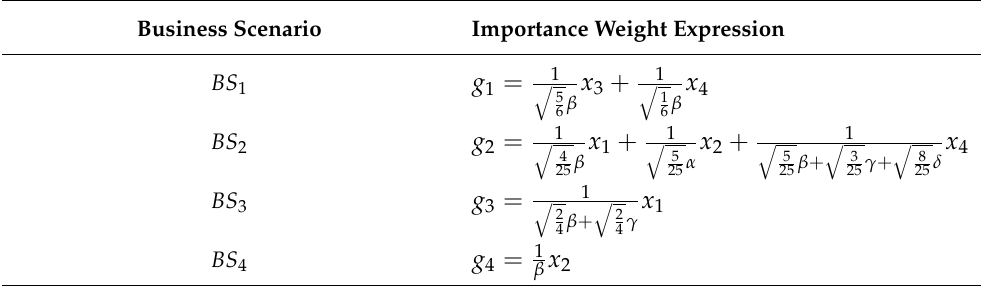
Table A7. Business scenarios’ importance weights represented by the database contribution x of the DBCAMS method.